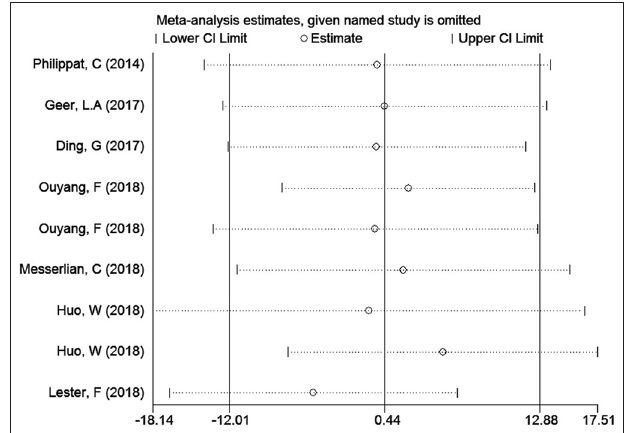
FIGURE 8 | The funnel plot of TCS exposure during pregnancy and neonatal birthweight.